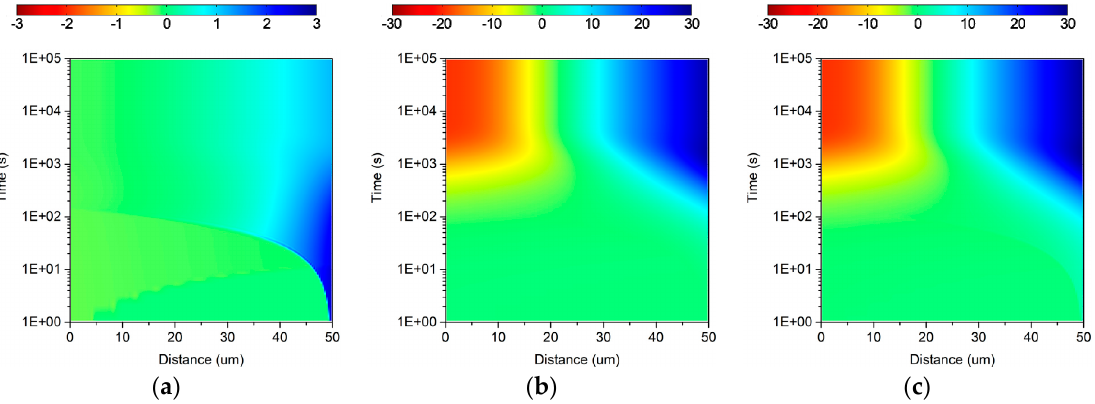
Figure 6. Space charge distribution at room temperature (=20 °C): (a) mobile charge density (C/m 3 ); (b) trapped charge density (C/m 3 ); (c) total charge density (C/m 3 ). ( b ) trapped charge density (C / m 3 ); ( c ) total charge density (C / m 3 ).